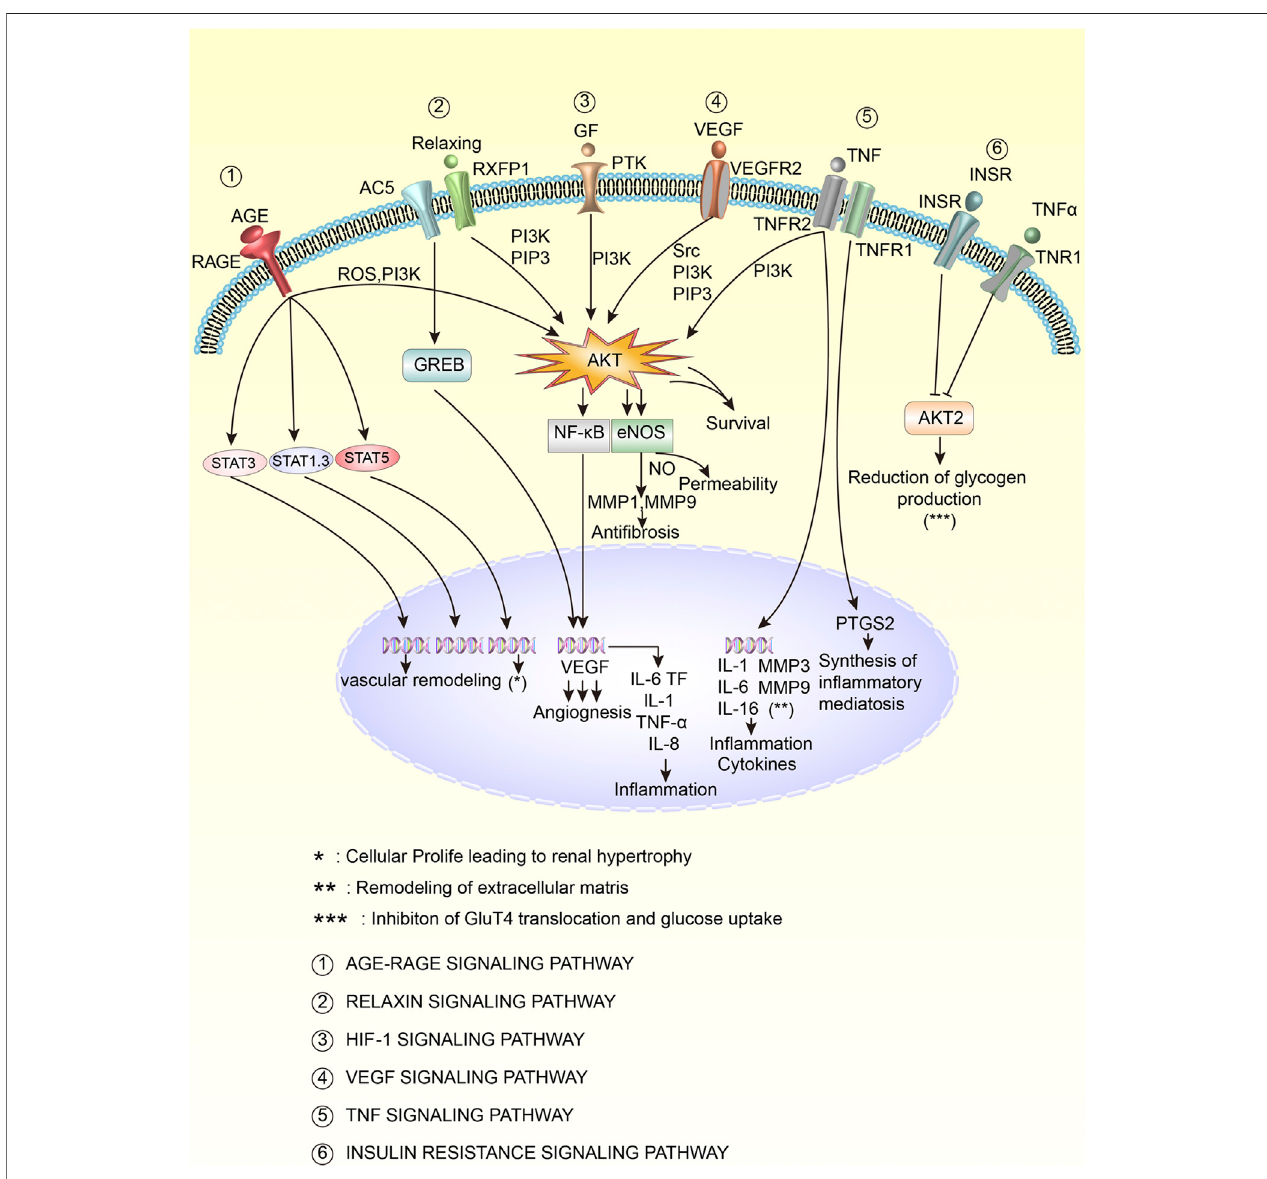
FIGURE 10 | Key mechanisms of TW in the treatment of DN patients. The activation is marked with an arrow, and the inhibition is marked with a vertical line at the top of the arrow.